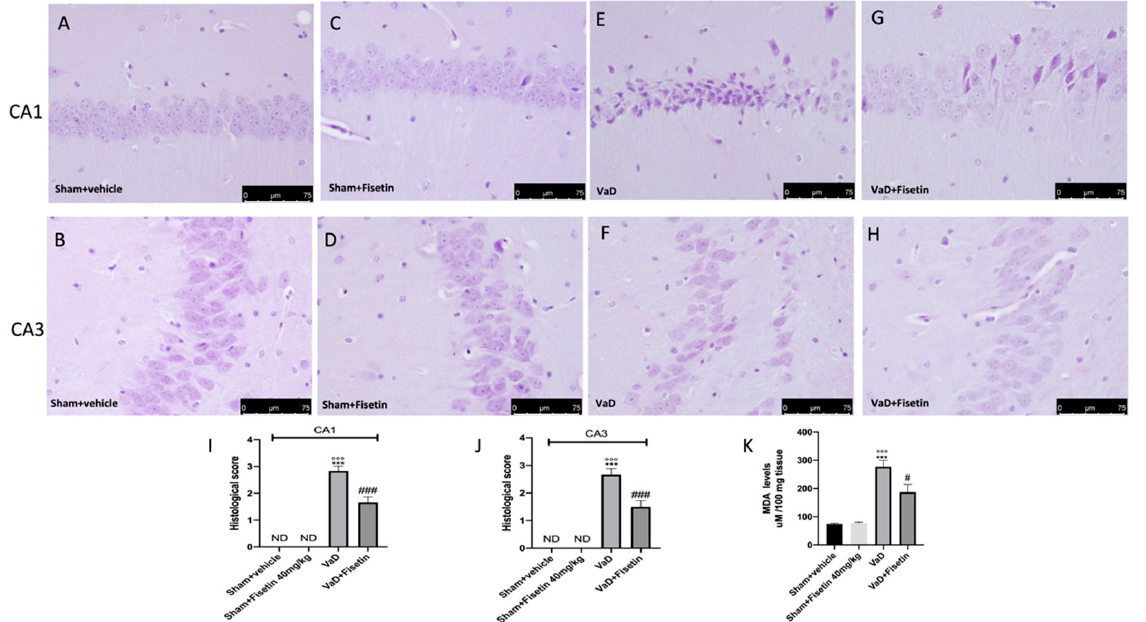
Figure 3. Fisetin administration on VaD induced histological damage and lipid peroxidation. Histological assessment in CA1 and CA3 regions, respectively, ( H & E ): ( A , B ) sham + vehicle group, ( C , D ), sham + Fisetin, ( E , F ) VaD + vehicle group, ( G , H ) VaD + Fisetin group, ( I , J ) histological scores. Figures are from at least three divided experiments. ( K ) MDA levels. Values are means ± SEM of 6 animals for each group. *** p < 0.001 vs. sham + vehicle, ◦◦◦ p < 0.001 vs. sham + Fisetin 40 mg/kg. # p < 0.05 vs. VaD, ### p < 0.001 vs. VaD. Scale bar: 75 µ m. Magnification (40 ×).